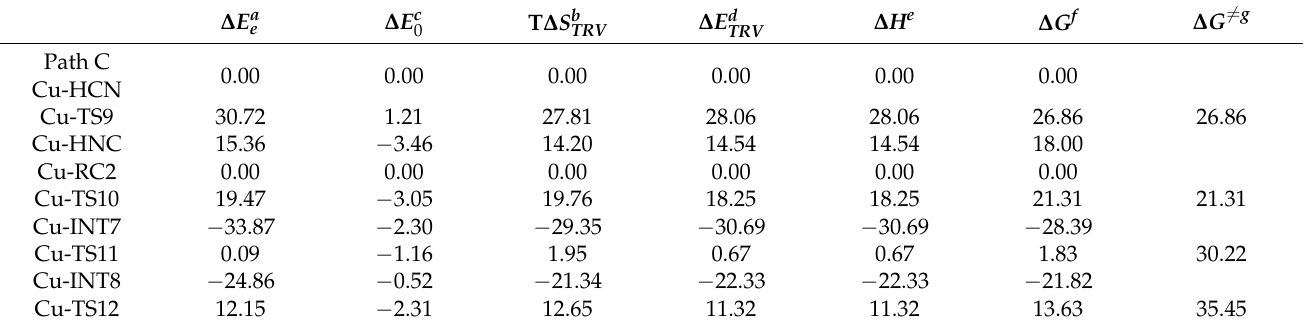
Table 3. Relative energies (in kcal/mol) with respect to the reactant complex (RC) for the catalytic hydrolysis of HCN with Cu-ZSM-5 in the gas phase of path C using the B3LYP/6–31++G